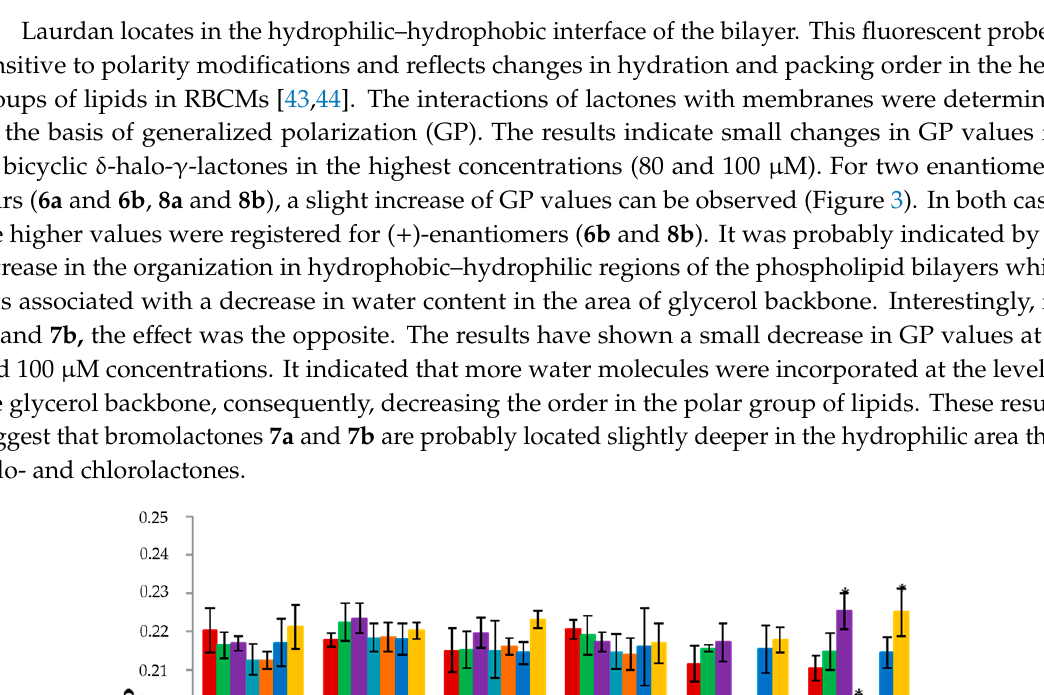
Figure 2. Values of anisotropy (A) of DPH probe for RBCMs (control) and RBCMs with addition of compounds 6a , b , 7a , b , 8a , b at 37 ◦ C. Values are mean ± SEM. Values are not significantly ( p < 0.05) different from control.